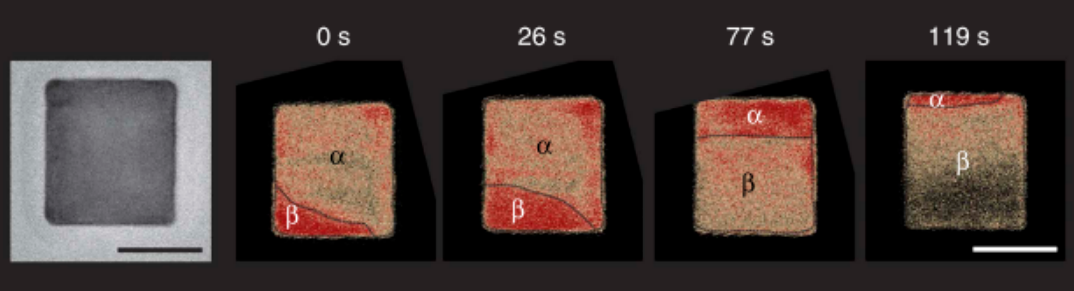
Figure 13. Still frames of the metal–hydride phase transformation in a 36 nm Pd nanocube as followed with STEM. The dotted lines represent the approximate locations of the phase boundaries (scale bar 25 nm). Reproduced with permission from [114] (copyright 2017 Springer Nature).